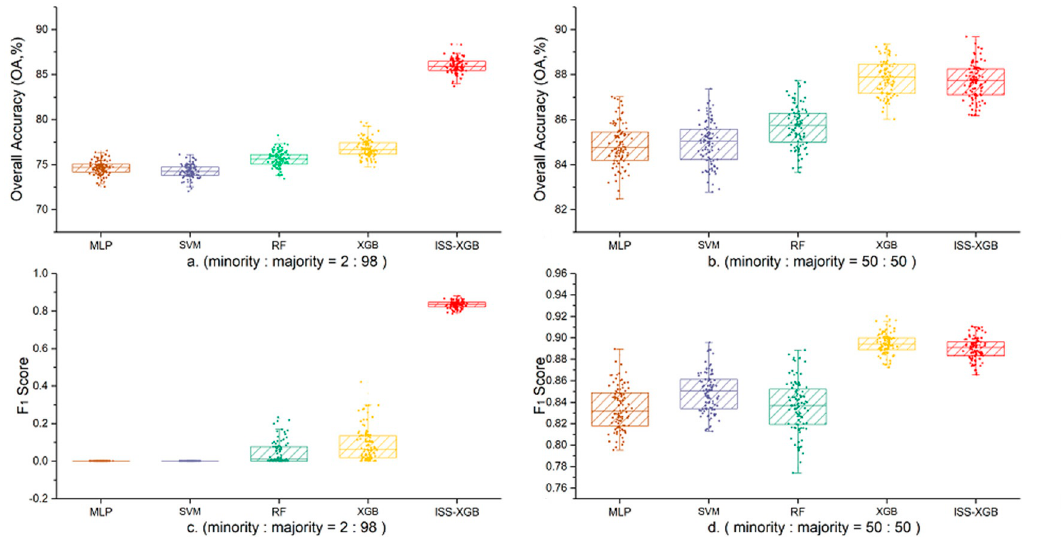
Figure 5. Box plots of OA and F 1 scores for Area 6 with 100 trials using di ff erent imbalanced samples. Left Column: performance with samples at minority:majority = 2:98; Right Column: performance with samples at minority:majority = 50:50. Sub-figure ( a , b ) are the box plots on OA by five methods with di ff erent sample imbalance (( a ). 2:98; ( b ). 50:50). Sub-figure ( c , d ) are the box plots on F 1 scores by five methods with di ff erent sample imbalance (( c ). 2:98; ( d ).